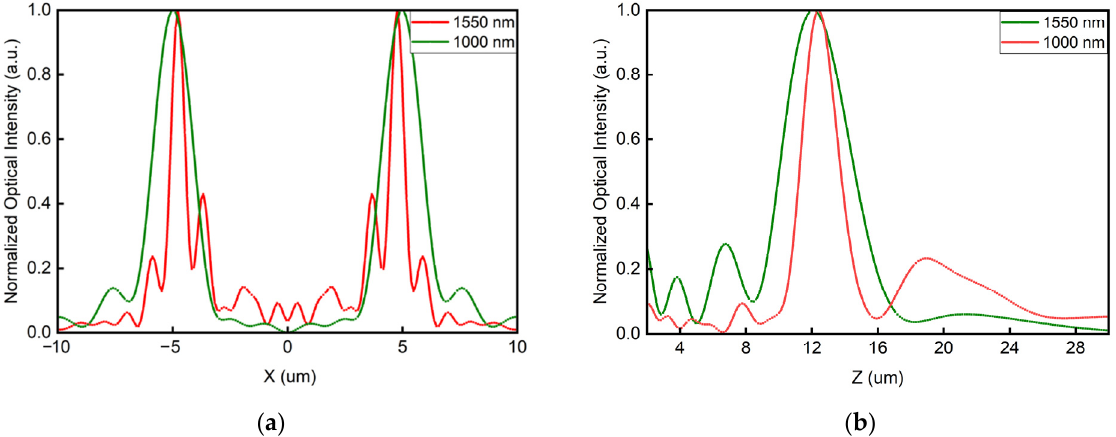
Figure 8. Optical intensity distribution under LP light. ( a ) Normalized optical intensity along x -axis at the focal plane. Red and green lines stand for different distribution at 1550 and 1000 nm, respectively. ( b ) Normalized optical intensity along z-direction when 𝑥 is − 5 µm and 𝑦 is 0. Red and green lines stand for different distribution at 1550 and 1000 nm, respectively.